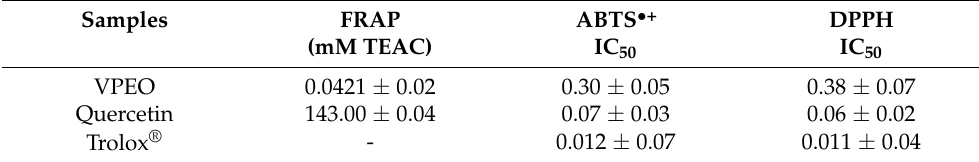
Table 2. Antioxidant activities of essential oil of Valeriana pilosa .